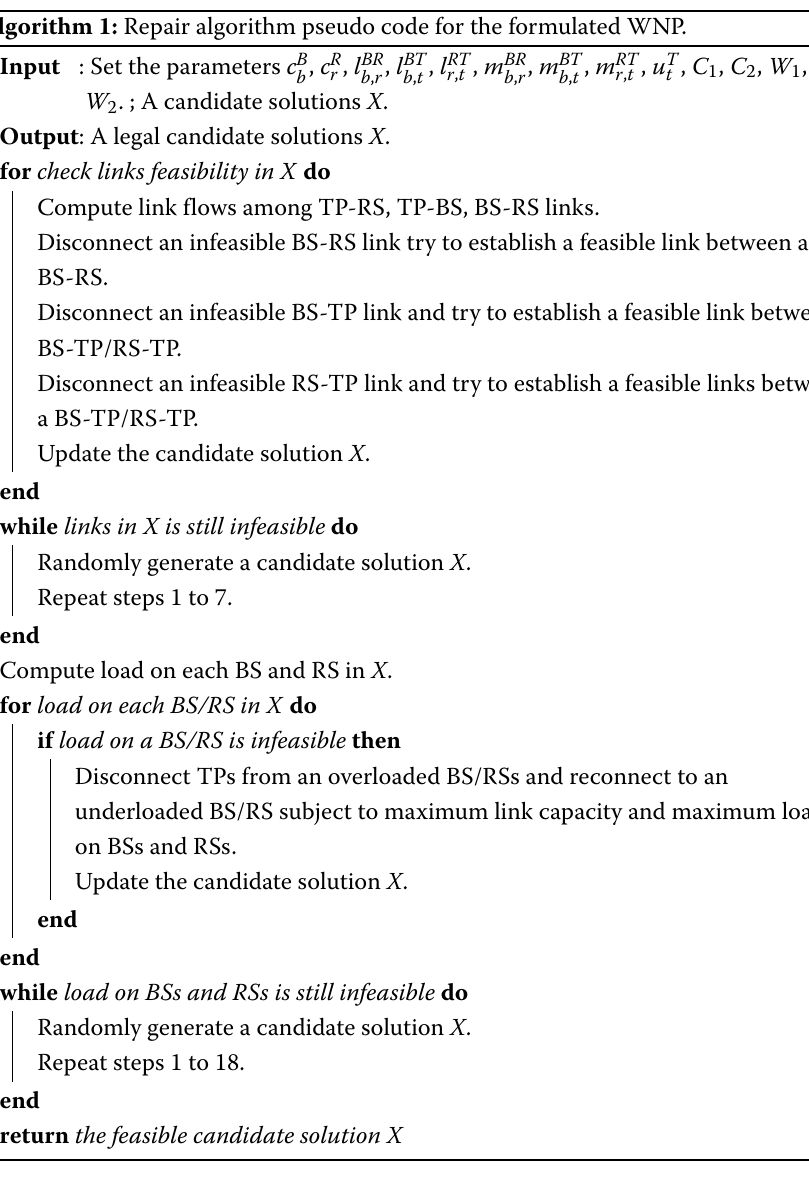
Algorithm 1: Repair algorithm pseudo code for the formulated